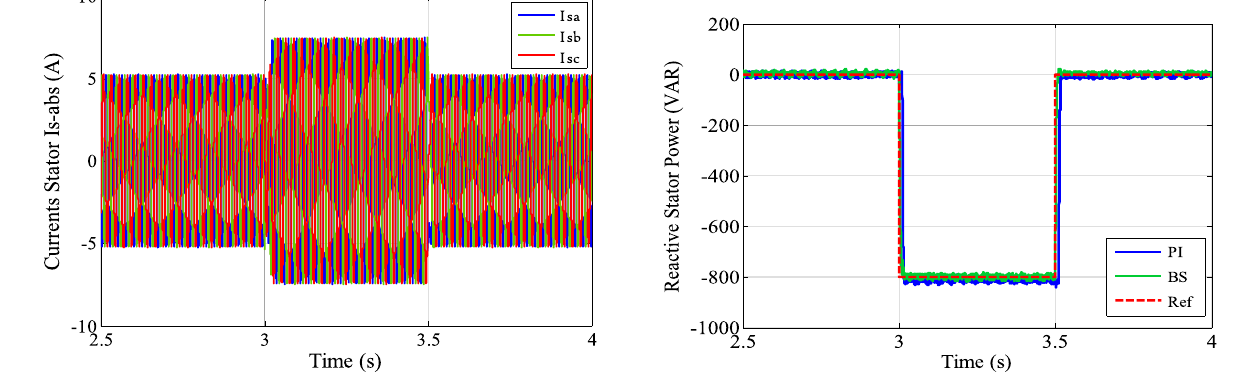
Fig. 17 Stator Currents I s-abc en (A)